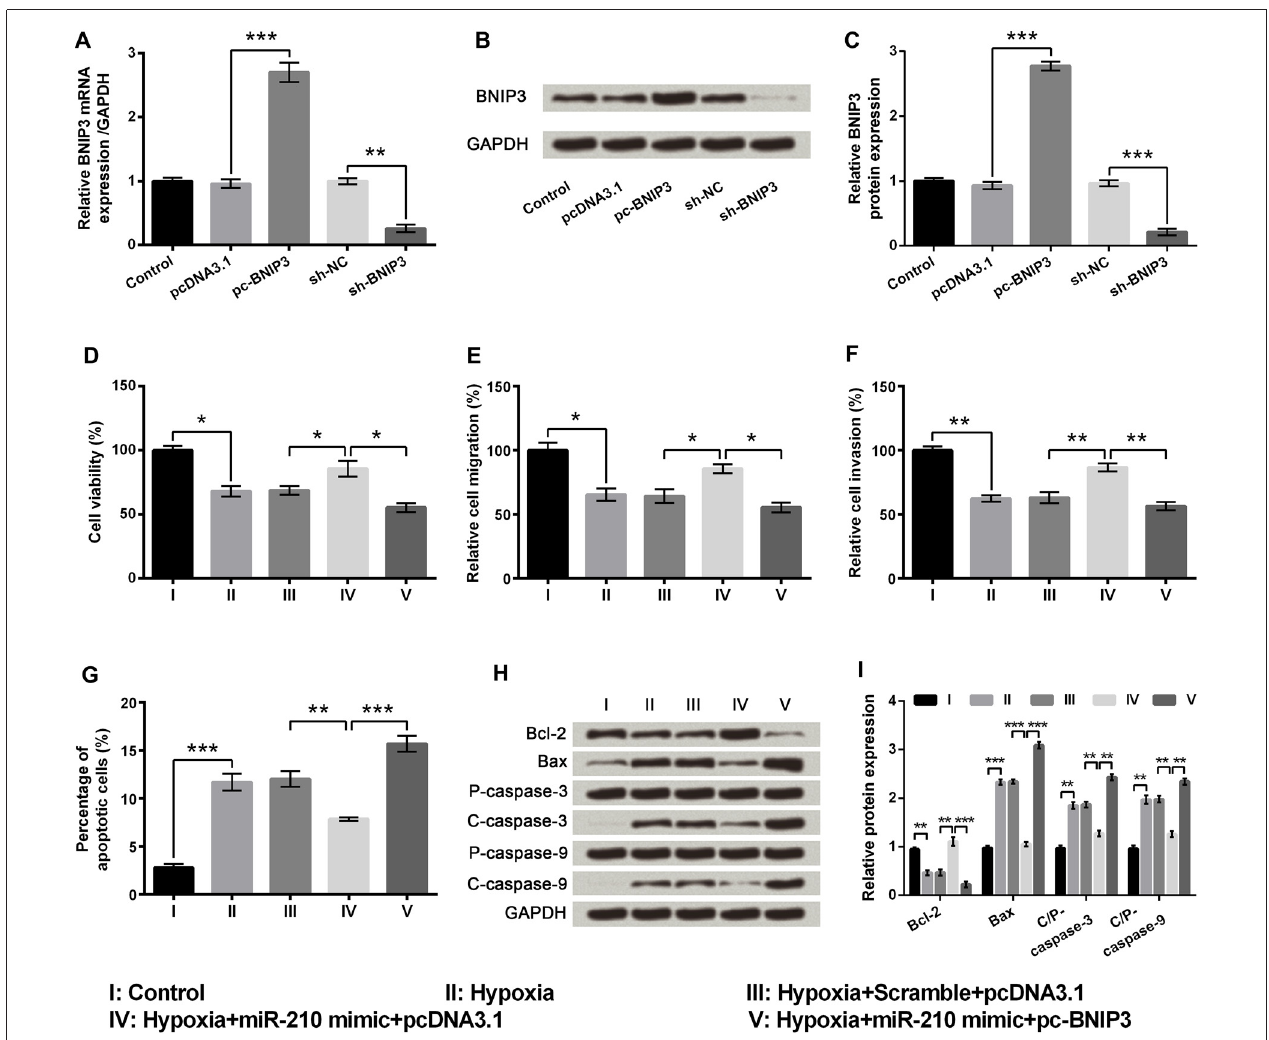
FIGURE 6 | MicroRNA (miR)-210 overexpression ameliorated hypoxia-induced injury in PC-12 cells by down-regulating BNIP3 expression. (A) Aberrant mRNA expression of BNIP3 in PC-12 cells. (B,C) Aberrant protein expression of BNIP3 in PC-12 cells. (D–G) Effects of miR-210 overexpression on cell viability, migration, invasion and apoptosis in hypoxia-treated PC-12 cells were reversed by up-regulating BNIP3. (H,I) Western blotting analysis of apoptosis related factors. Data presented are the mean ± SEM of at least three independent experiments. ∗ P < 0.05; ∗∗ P < 0.01; ∗∗∗ P < 0.001. BNIP3, Bcl-2 adenovirus E1B 19 kDa-interacting protein 3; Bcl-2, mammalian B cell lymphoma-2; Bax, Bcl-2-associated X protein; C/P-, cleaved/pro; sh-NC, U6/GFP/Neo plasmid carrying a non-targeting sequence; sh-BNIP3, U6/GFP/Neo plasmid carrying sh RNA against BNIP3; pc-BNIP3, pcDNA3.1 carrying the full-length of